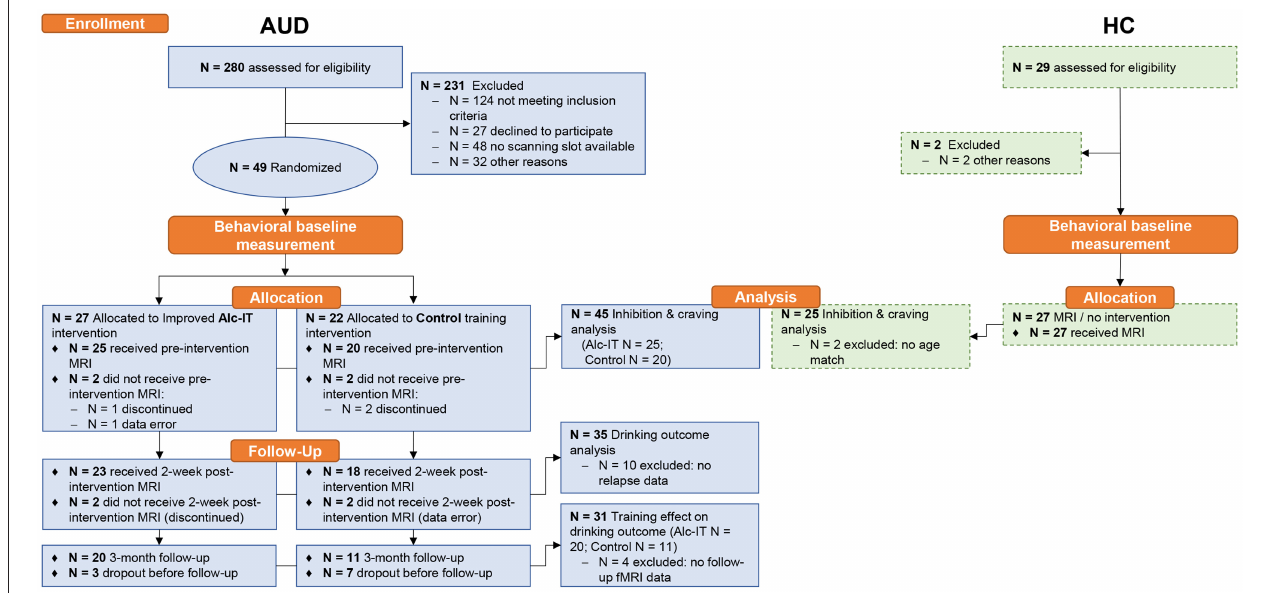
FIGURE 1 | Study design of the GNG-fMRI sub-study within the INTRA project. Dashed box contours indicate data that is shown in Supplementary Material . Alc-IT, alcohol-specific inhibition training; AUD, alcohol use disorder; GNG, Go-NoGo task; HC, healthy controls; MRI, magnetic resonance imaging; N, sample size.